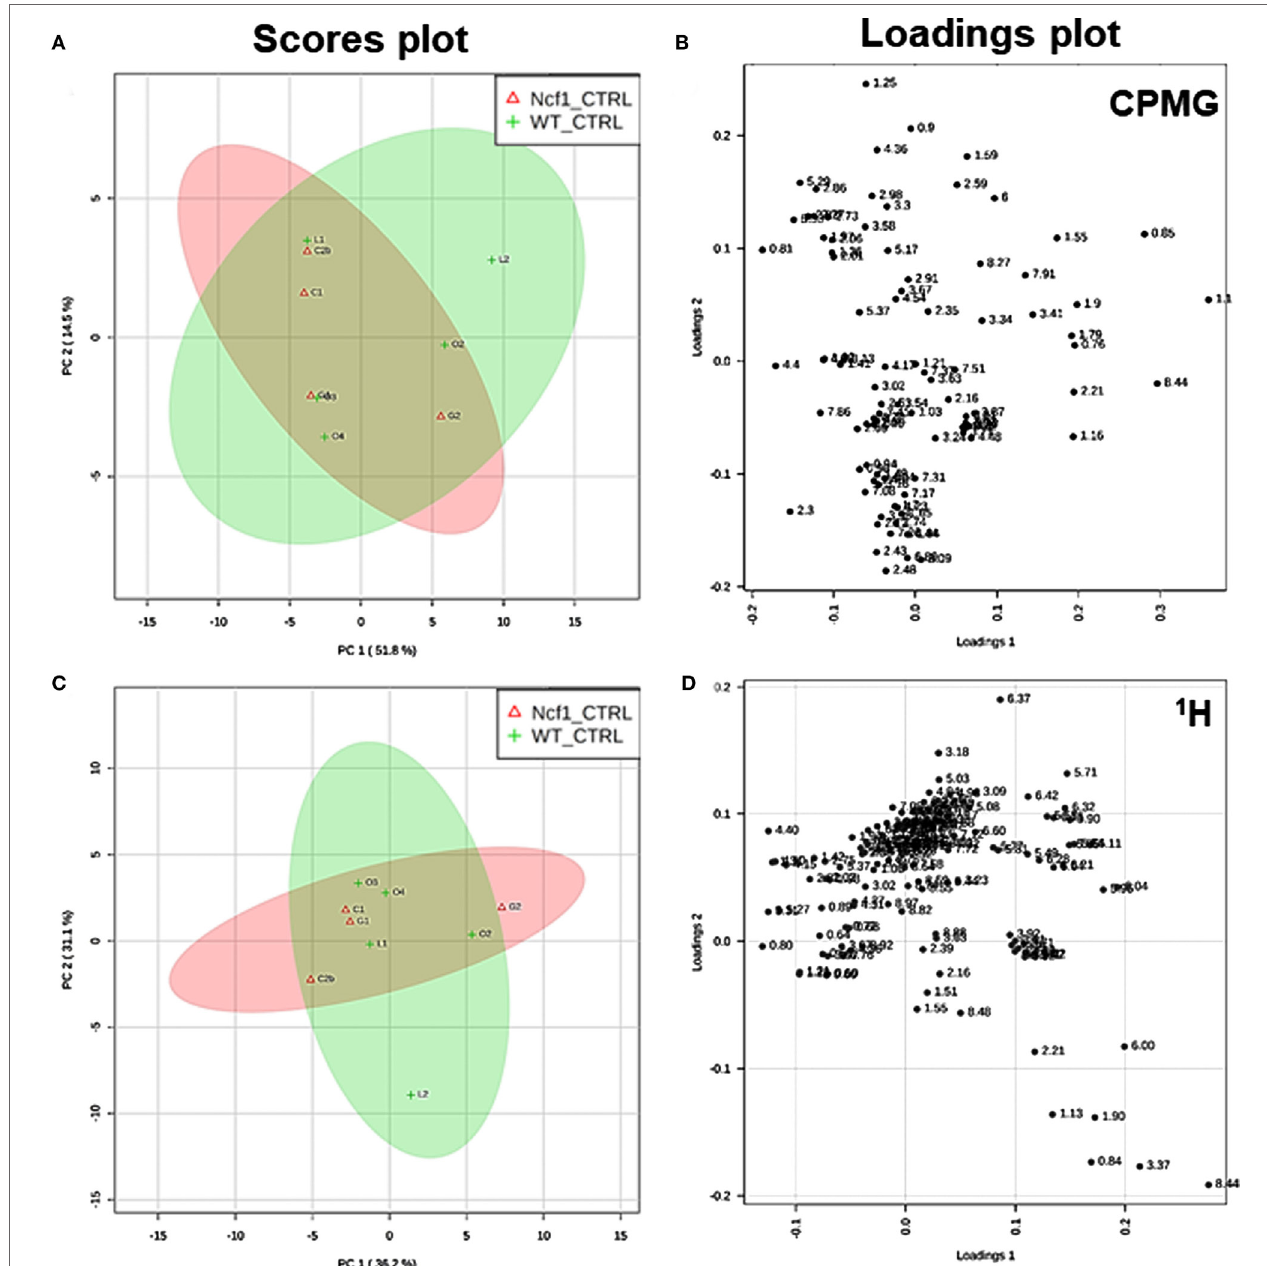
FigUre 6 | Control wild-type (WT) and Ncf1-mutant (Ncf1) mice display similar metabolomic profiles showing no difference in small molecule metabolites and lipid and macromolecular fractions. The scores plot (a) accounts for 66.3% of the total variance (PC1 = 51.8%, PC2 = 14.5%) and the loadings plot (B) shows the δ of each variable (bucket) for the principal component analysis (PCA) analysis of Carr–Purcell–Meiboom–Gill (CPMG) spectra of Ncf1 and WT control groups. The CPMG pulse sequence suppresses the broad signals from macromolecules allowing analyze small molecule metabolites. The scores plot (c) summarizes 67.3% of the total variance (PC1 = 36.2%, PC2 = 31.1%) and the loadings plot (D) shows the δ of each variable (bucket) of the PCA analysis of 1 H spectra of Ncf1 vs WT control groups. The 1 H spectra allow analysis of the aqueous lipid fraction and other